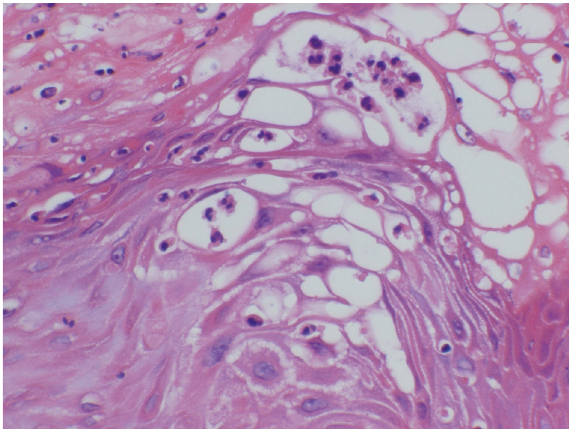
Figure 4: Intraepithelial